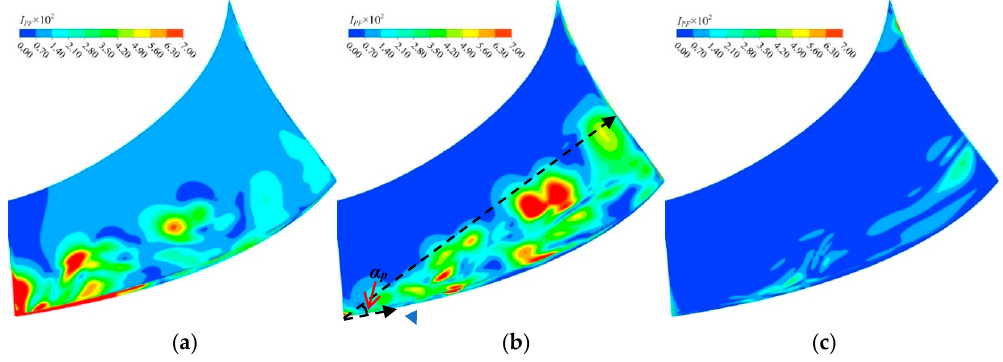
Figure 29. Distribution of pressure fluctuation intensity on pressure surface for three flow rates [40]. ( a ) 0.8 Q ; ( b ) 1.0 Q ; ( c ) 1.2 Q .